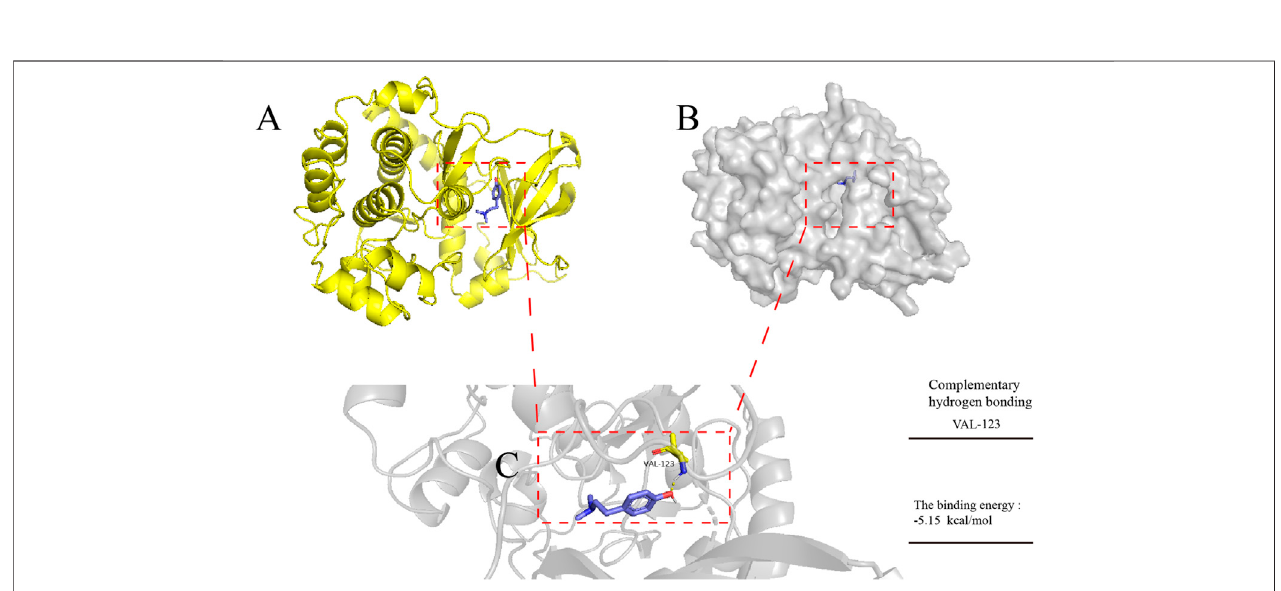
FIGURE8| MoleculardockingsimulationofhordeninewithAKT.AutoDocktoolswereusedtopredictthedockingofproteinkinaseB(AKT)proteinwithhordenine, and PyMOLwasused toplot the binding mode. (A) Three-dimensional (3D) model ofAKT protein binding with ahordenine-cartoon pattern, AKT protein No. 3OW3. (B) Three-dimensional model of AKT protein binding to the hordenine-surface model. (C) Amino acid residues of AKT protein hydrogen bonding with hordenine. Blue represents hordenine and yellow represents the amino acid residues of AKT protein.